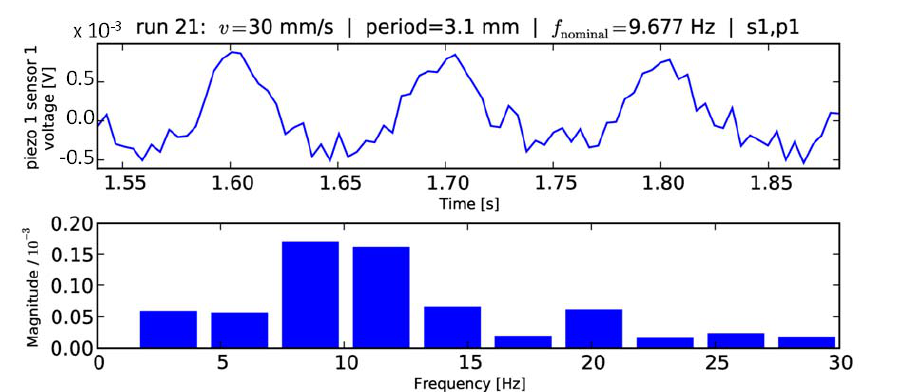
Figure 5. As Figure 4, but for a different data series and a narrower window of 0.35 s, showing higher discretization error with naïve Fourier